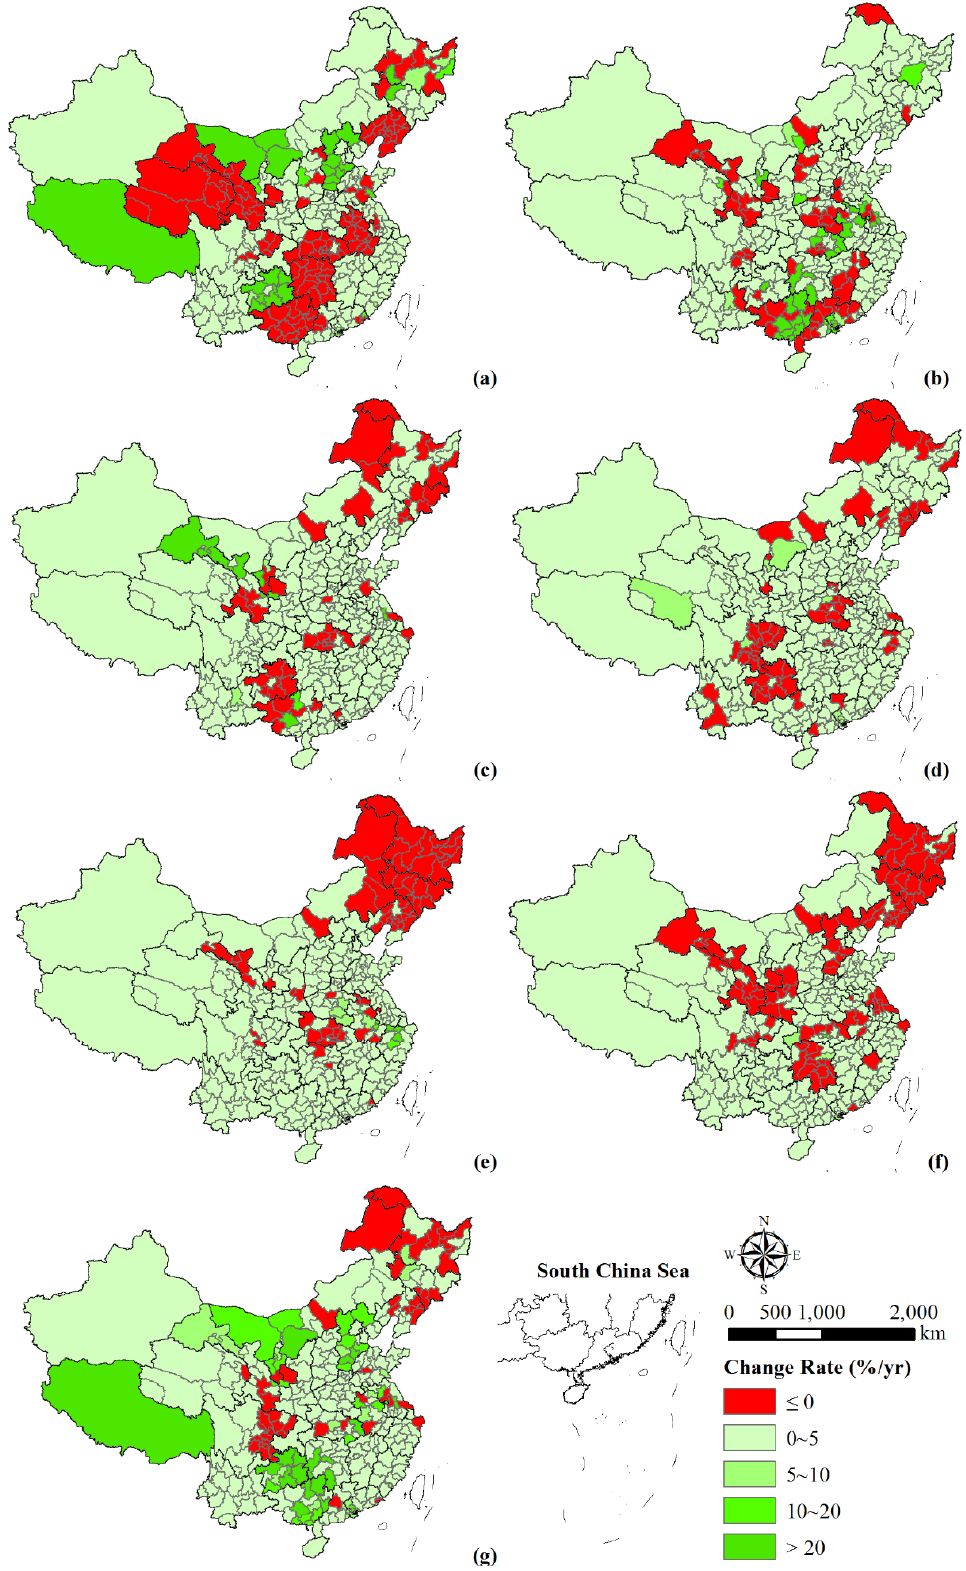
Figure 3. Spatial variation of the change rate of population during 1990–1995 ( a ), 1995–2000 ( b ), 2000–2005 ( c ), 2005–2010 ( d ), 2010–2015 ( e ), 2015–2018 ( f ), and 1990–2018 ( g ). Note: ≤ 0 denotes negative growth in population, 0–5 is low growth rate, 5–10 is medium growth rate, 10–20 is rapid growth rate, and >20 is high growth rate.